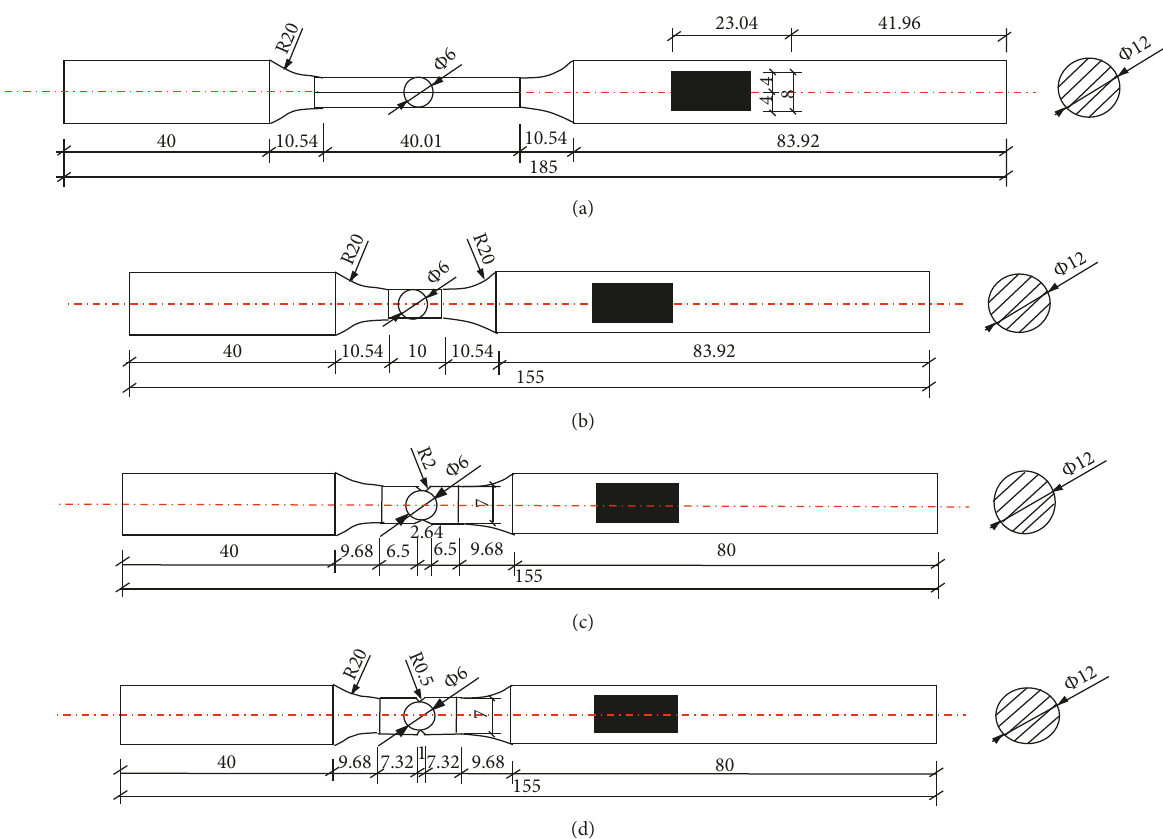
Figure 3: Smooth and notched round bars (mm). (a) B-6-SB and B-6-SH. (b) B-6-B and B-6-H. (c) B2-6-B and B2-6-H. (d) B0.5-6-B and